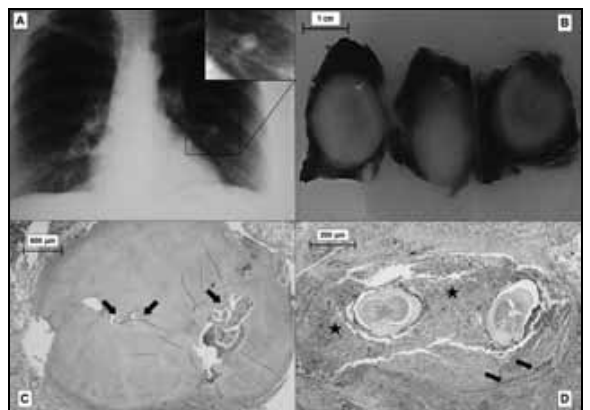
Figura 2 – (A) radiografia de tórax da paciente (caso 2) com “lesão em moeda” no lobo inferior do pulmão esquerdo; (B) macroscopia do nódulo pulmonar em cortes; (C) imagem microscópica panorâmica com os parasitas (setas) (pentacrômico de Movat); (D) microfotografia mostrando o parasita em dois cortes, envolvido por necrose (estrelas) circundada por tecido fibroso e infiltrado inflamatório. É possível identificar partes da camada elástica da artéria (seta) (pentacrômico de